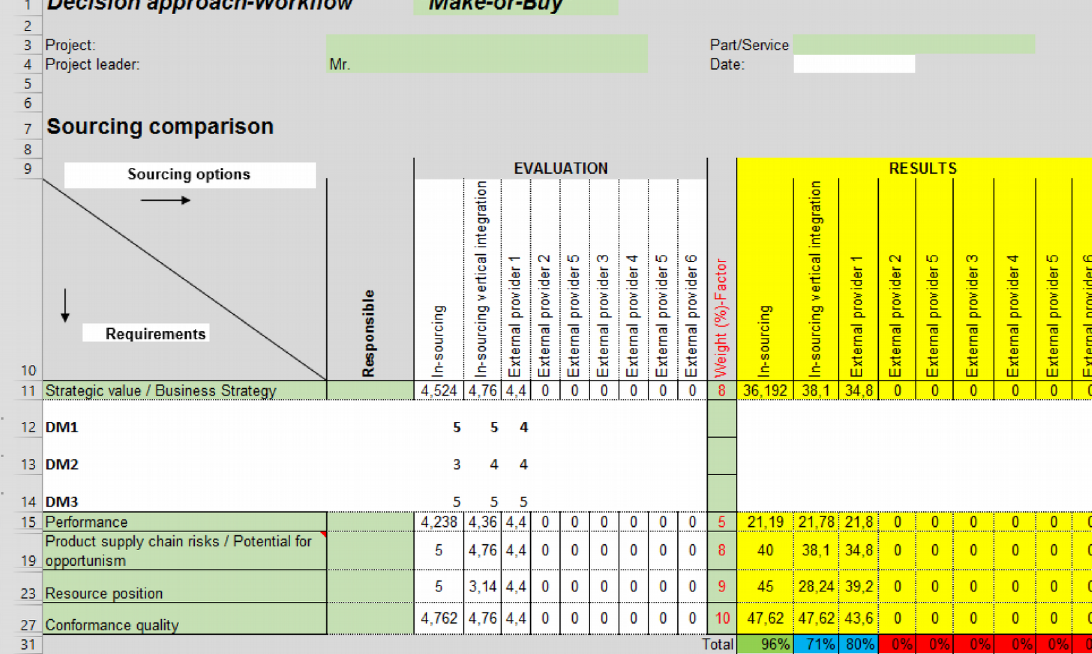
Table 3. Criteria for the operationalisation of the tool, case